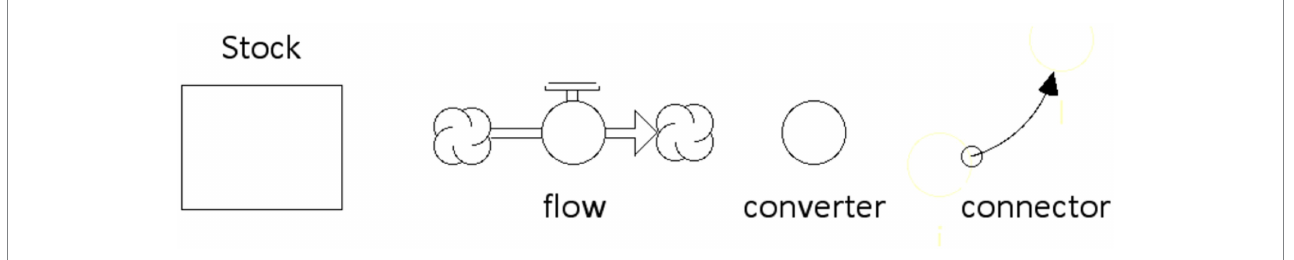
FIGURE 1 The SD modeling icons used in the Stella modeling